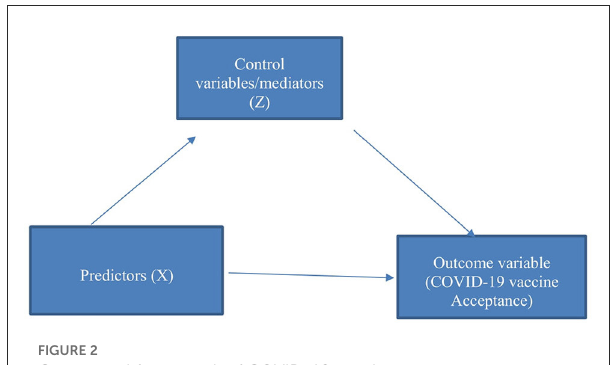
FIGURE2 Conceptual framework of COVID-19 vaccine acceptance.